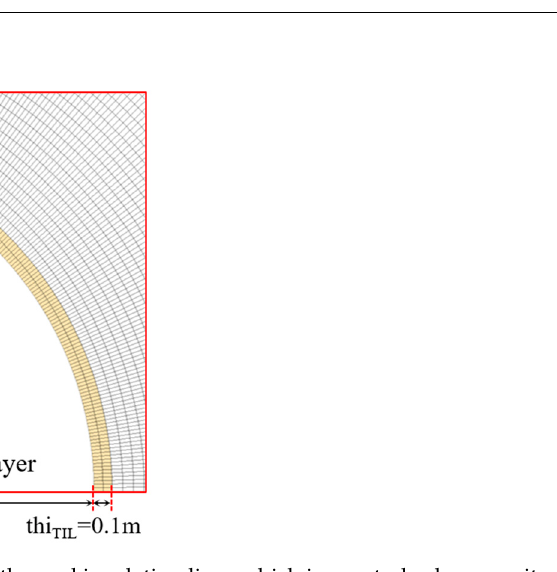
Figure 13. The meshing of thermal insulation liner which is quarterly shown as its symmetry.